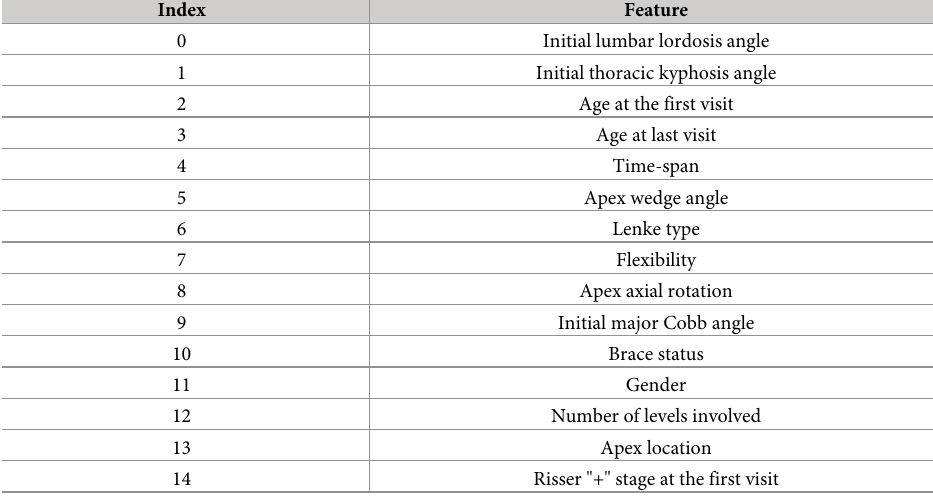
Table 3. Indices of input features to RF